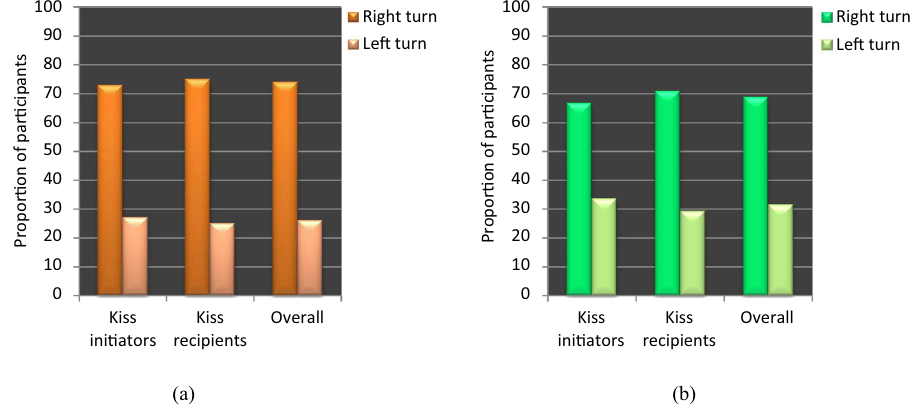
Figure 2. Proportions of participants turning head to the right or left during kissing. ( a ) Data provided by kiss initiators. ( b ) Data provided by kiss recipients. Two sets of head-turning data were obtained because each participant reported about the direction of his or her own head-turning as well as the direction of his or her partner’s head-turning while initiating or receiving a kiss, but without having any knowledge of the partner’s response.